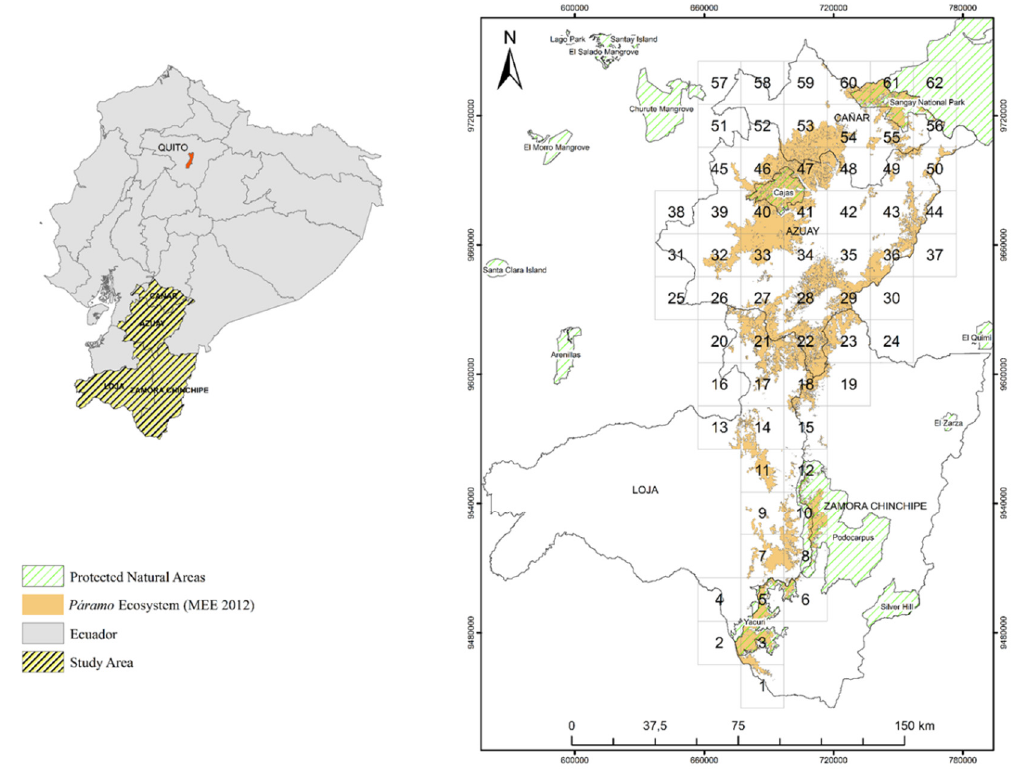
Figure 1. Ecuador’s southern region.